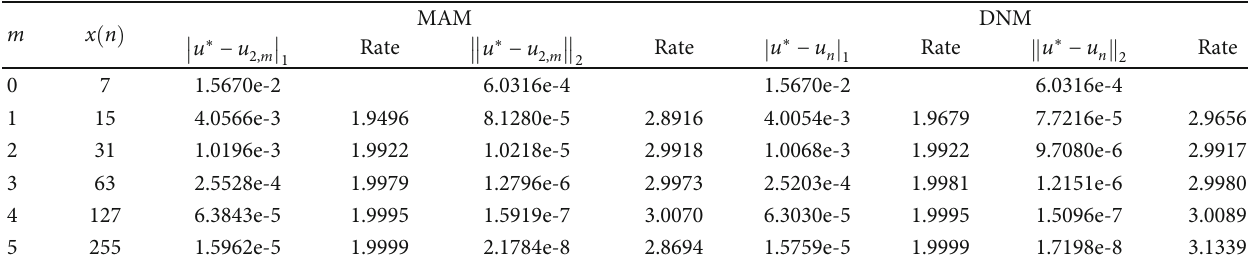
Table 4: Errors and convergent orders of MAM and DNM via quadratic basis in spatial direction with k = 2, τ = 0 : 001 , and α = 0 : 1 for Example 1.